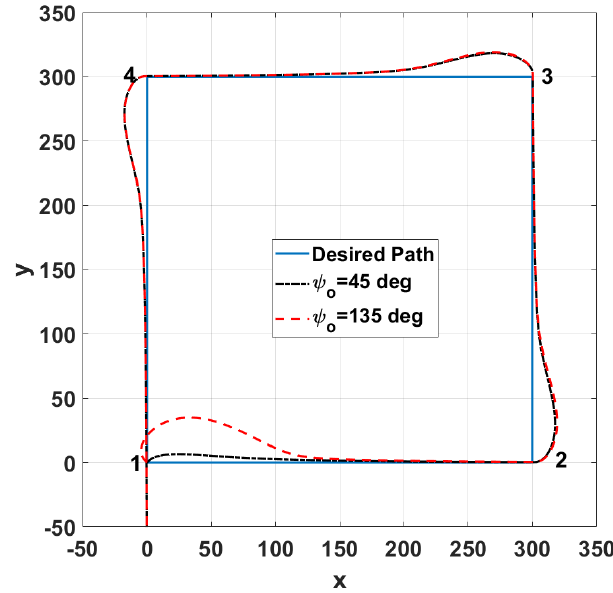
Figure 18. Effect of changing the initial flight direction.